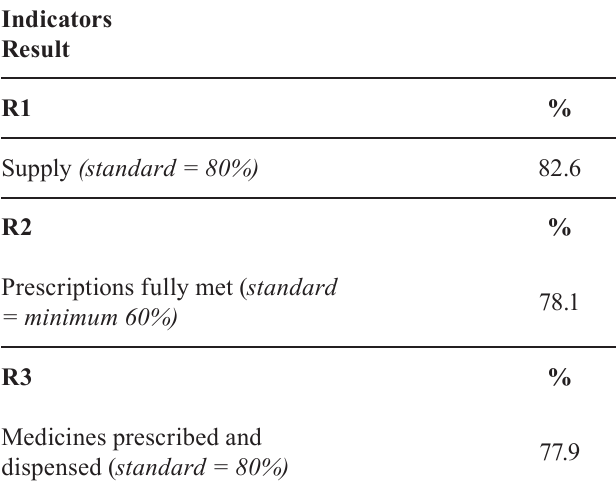
TABLE III - Result indicators (R1, R2 and R3) of PS in PHC, in 2015 and 2016.